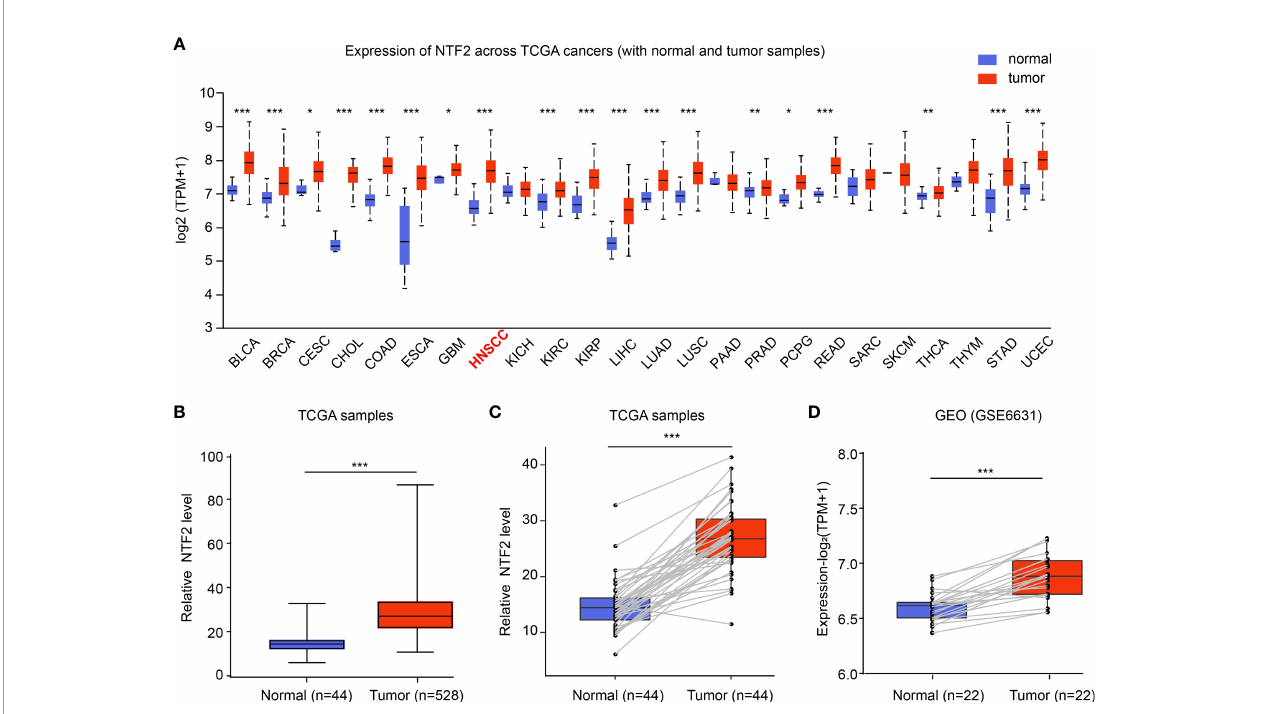
FIGURE 1 | Expression of NTF2 in HNSCC. (A) NTF2 expressions in different types of cancers were examined using the UALCAN database. (B) Analysis of NTF2 expression in HNSCC using TCGA database. Comparison of NTF2 mRNA levels in paired adjacent normal tissue and tumor tissue of HNSCC from TCGA (C) and GEO database (D) . *P < 0.05, **P < 0.01, ***P <